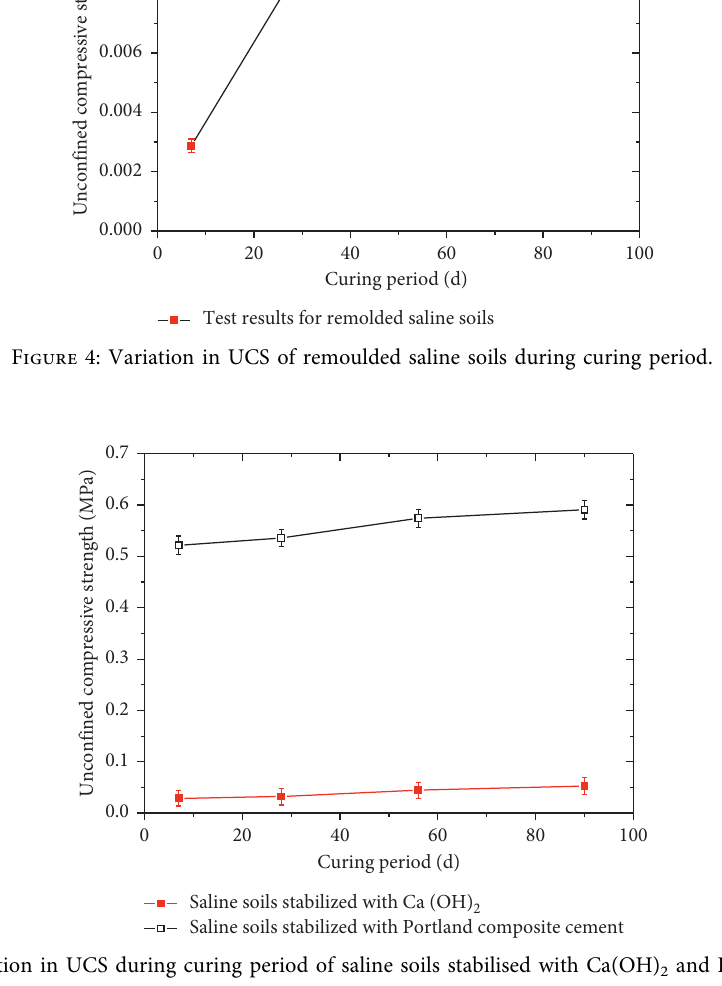
2 and Portland cement.